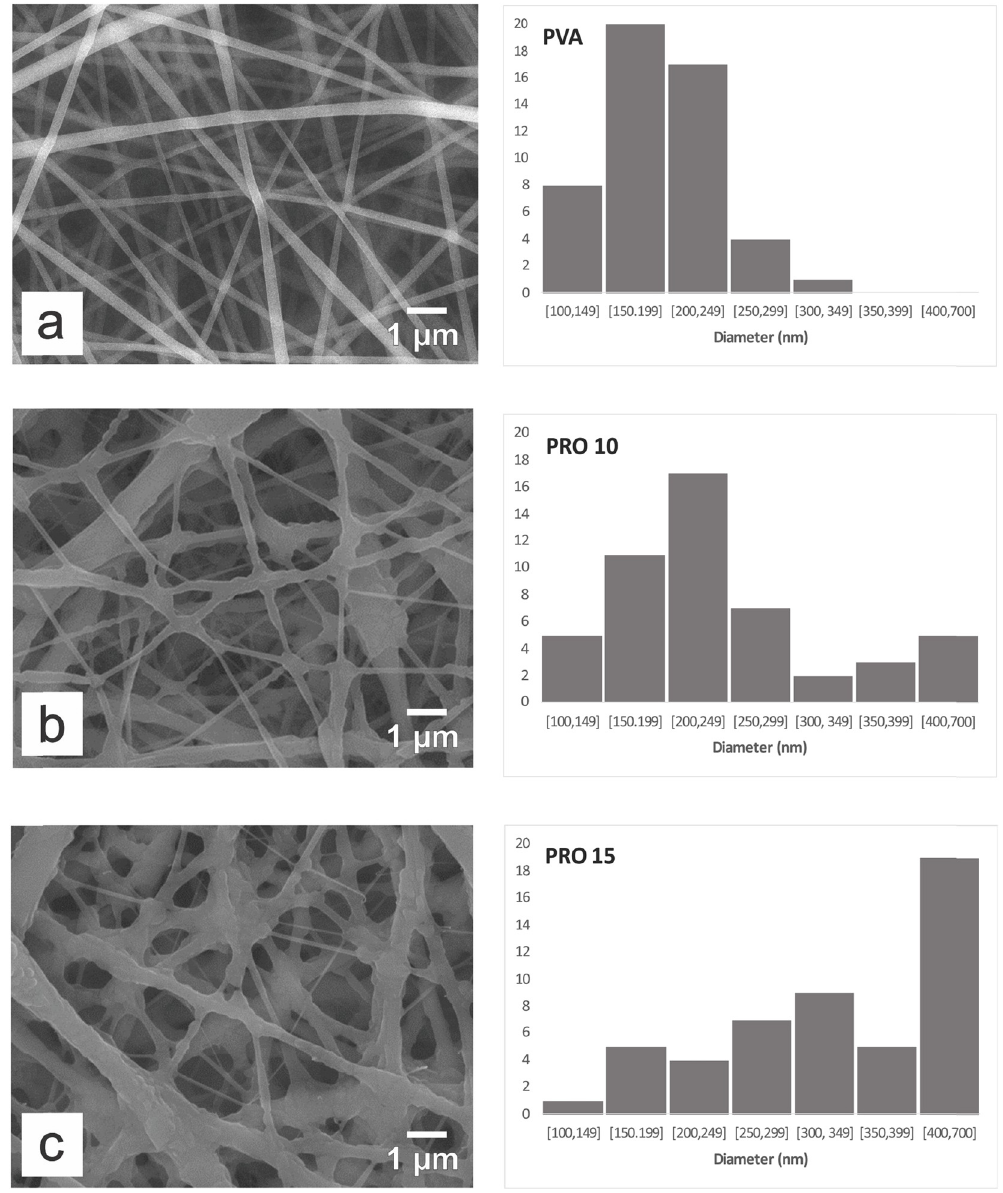
Figure 2: SEM micrograph of electrospun nano fi bers and distribution of fi bers: ( a ) PVA, ( b ) PRO 10, and ( c ) PRO 15.